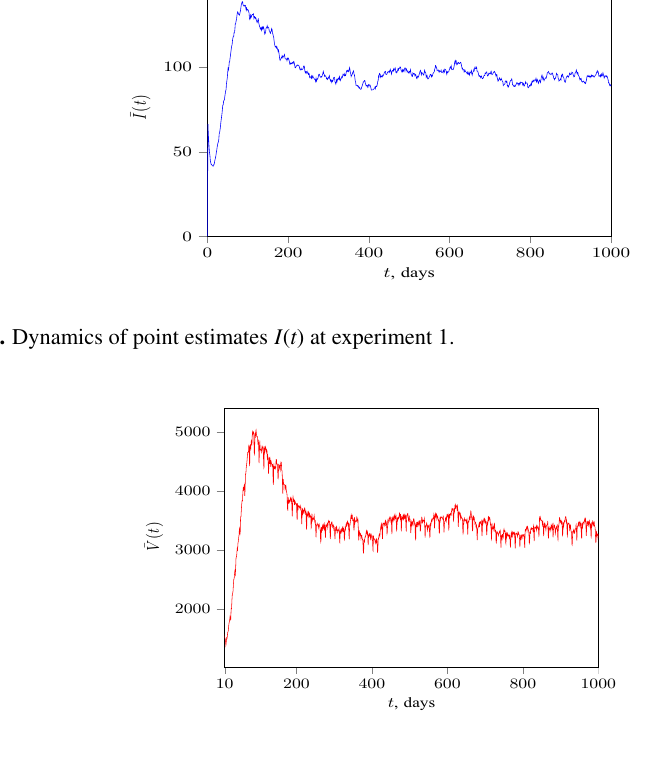
1 Figure 6. Dynamics of point estimates V ( t ) at experiment 1.